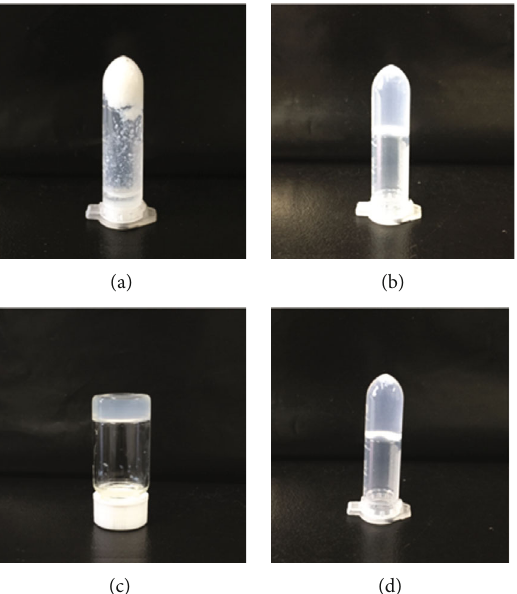
Figure 13: Macroscopic morphology of DMTCP gel formed in four solvents: (a) diethyl ether, (b) carbon tetrachloride, (c) bromododecane, and (d)